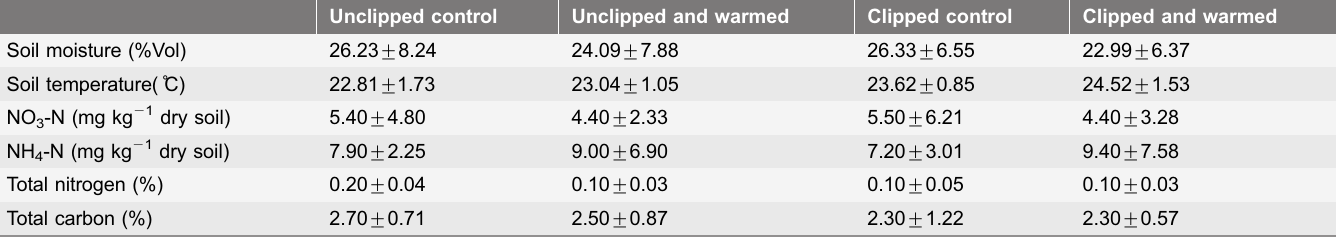
Table 1. Mean soil moisture, soil temperature, NO 3 N, NH 4 N, total nitrogen, and total carbon before incubation under four treatments in May